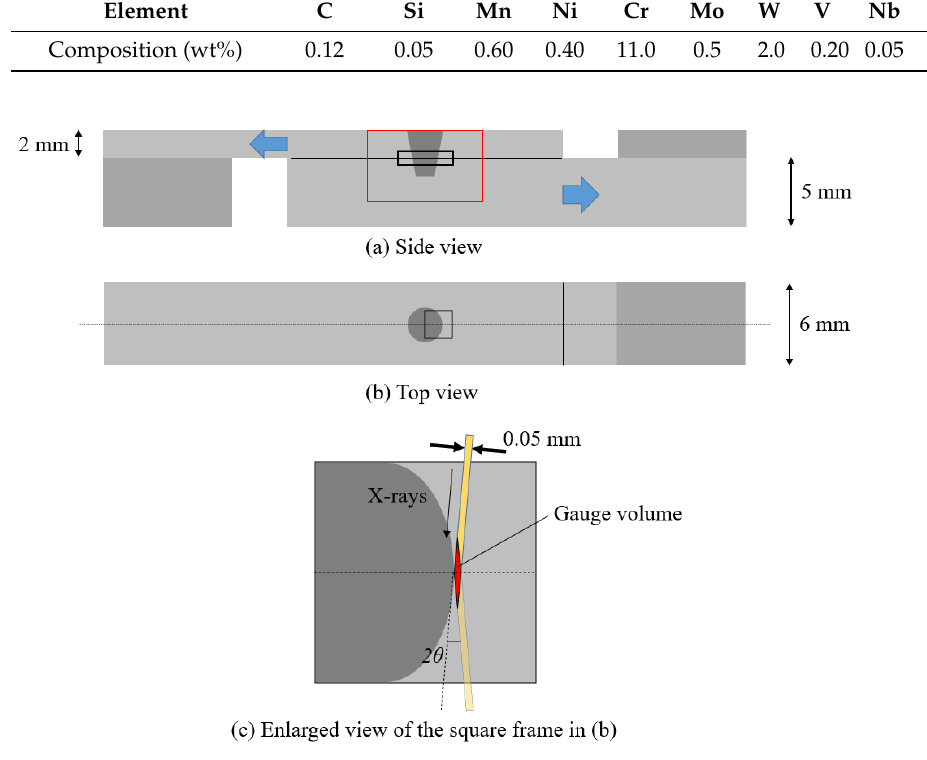
Figure 1. Specimen. Figure 1.